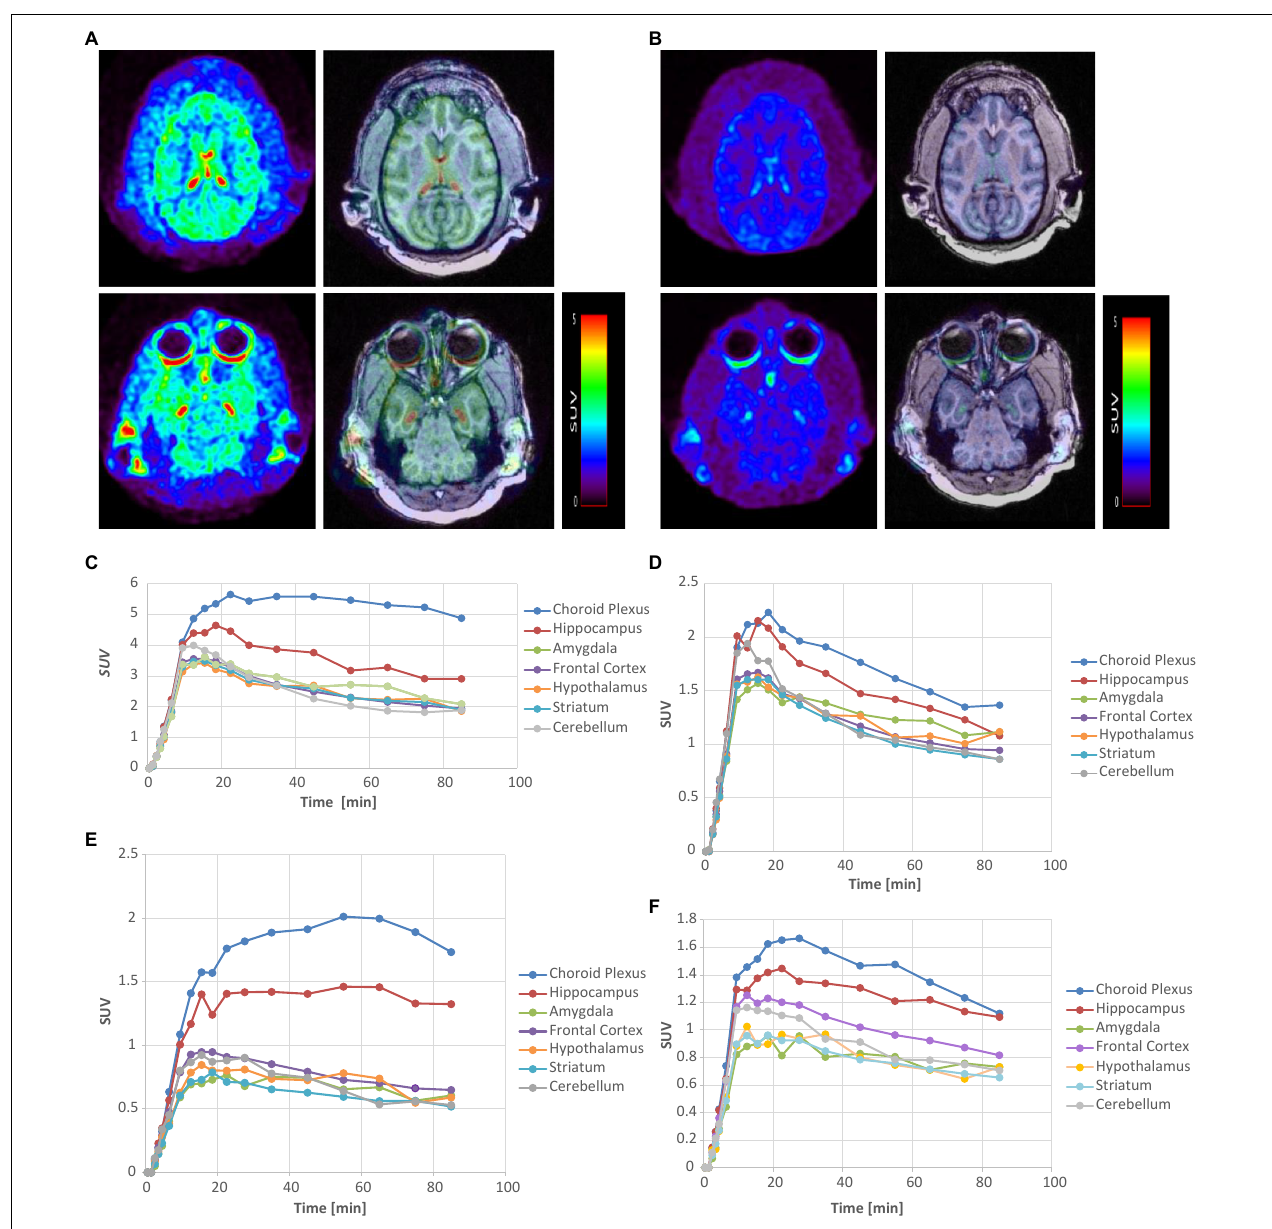
FIGURE 3 | PET-MRI analysis of [ 11 C] 6 and [ 11 C] 9 in rhesus monkey. (A) MicroPET images of [ 11 C] 6 (left) and corresponding fused PET/MRI images summed over all time at baseline. (B) MicroPET images [ 11 C] 6 (left) and corresponding fused PET/MRI images summed over all time after pretreatment with 0.1 mg/kg of SB-242084. (C) Time-activity curves of [ 11 C] 6 for brain regions of interest at baseline study. (D) Time-activity curves of [ 11 C] 6 for brain regions after pretreatment with SB-242084. (E) Time-activity curves of [ 11 C] 9 for brain regions of interest at baseline study. (F) Time-activity curves of [ 11 C] 9 for brain regions after pretreatment with